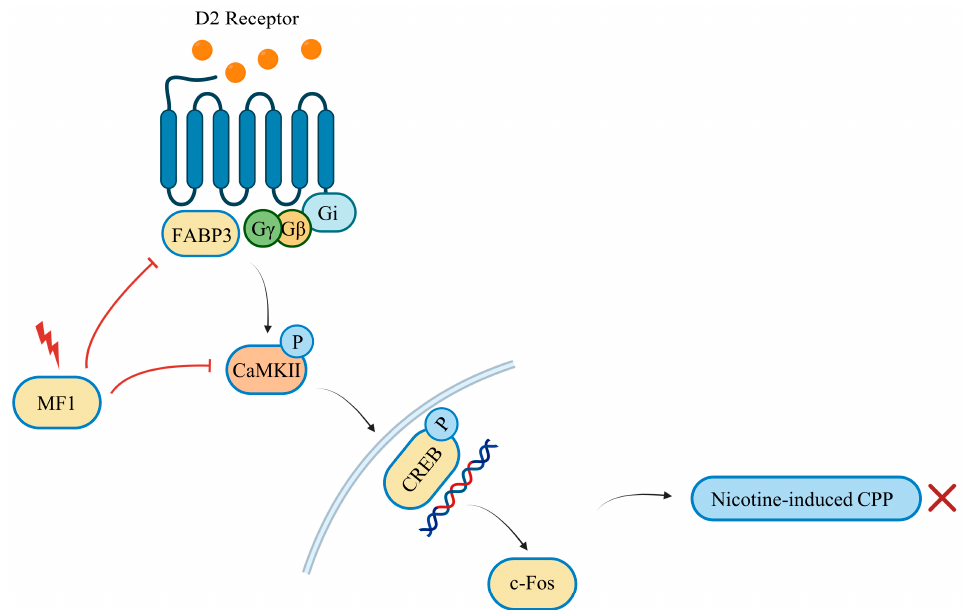
Figure 6. Schematic representation of the inhibition of nicotine-induced CPP behaviors in the NAc by MF1. Nicotine-induced activation of D2R/FABP3 signaling is inhibited by MF1 treatment, which subsequently prevents CaMKII and CREB activation and further reduces c-Fos transcriptional expression. The inhibition of CaMKII/CREB phosphorylation and the reduction in c-Fos expression are insufficient to elicit nicotine-induced CPP behaviors in mice.